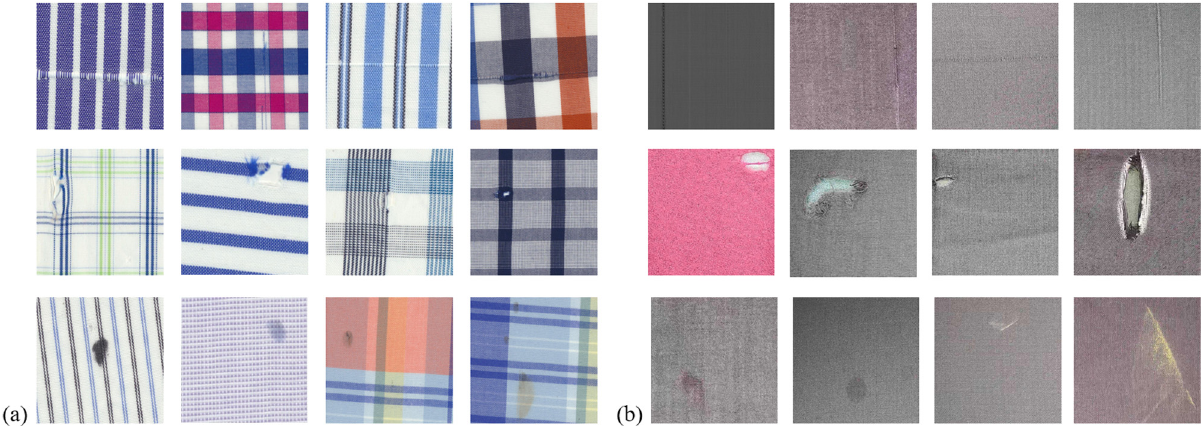
Figure 3: Parts of collected fabric defected images: ( a ) fabrics defected images with Texture_1; and ( b ) fabrics defected images with Texture_2.